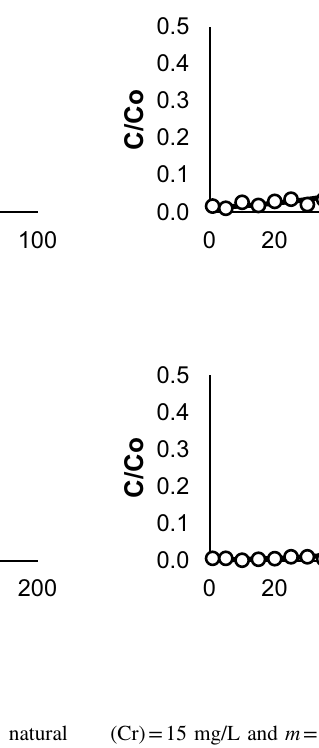
(Cr) = 15 mg/L and m = 1.5 g; c Co (Ni) = 15 mg/L and m = 1.5 g; d Co (Ni) = 25 mg/L and m = 1.5 g. Filled circle represents the break- point in each case